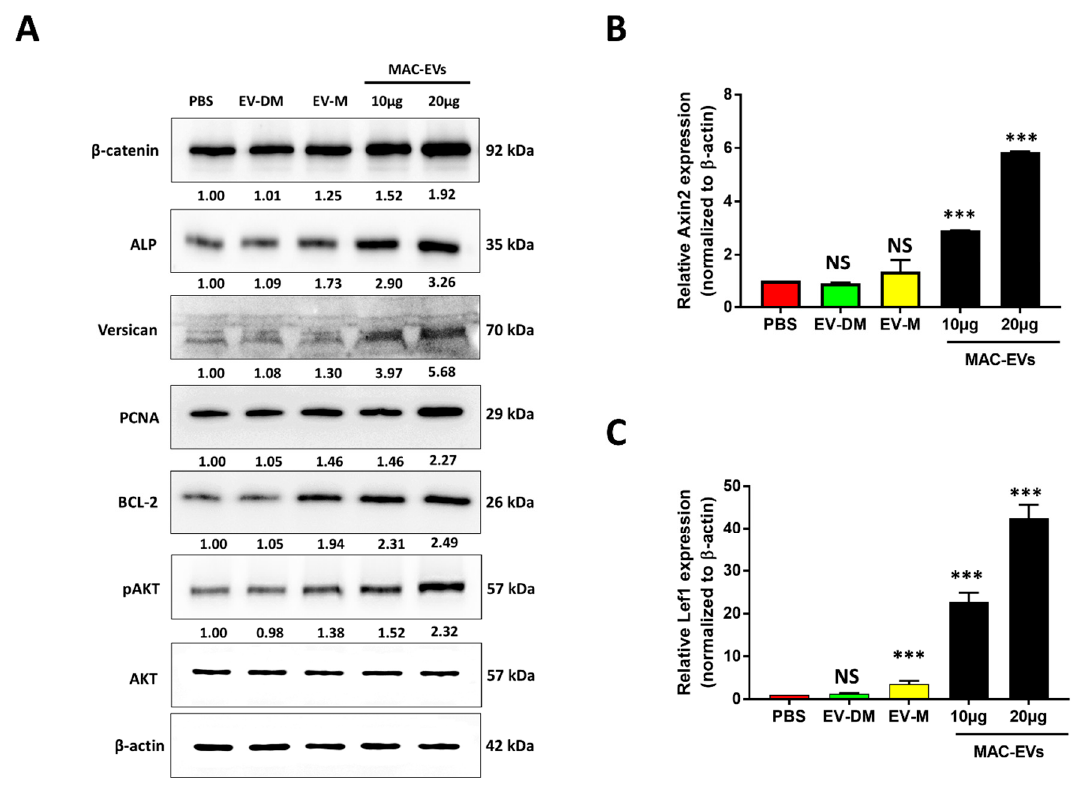
Figure 4. MAC-EV treatment leads to increased levels of hair-inductive proteins and survival and proliferation markers and activates the Wnt / β -catenin signaling pathway. ( A ) Western blot analysis of β -catenin, Versican and ALP, pAkt, Akt, Bcl-2, PCNA, and β -actin levels in DP cells after 24 h treatment of MAC-EVs. ( B , C ) qPCR results of mRNA expressions of Axin2 and LEF1 in DP cells treated with EV-DM, EV-M, and MAC-EVs for 24 h ( n = 3). Means ± SD of triplicate experiments are shown. *** p < 0.001. Student’s t-test was used for comparison. EV-M; media containing EVs; EV-DM; media containing no